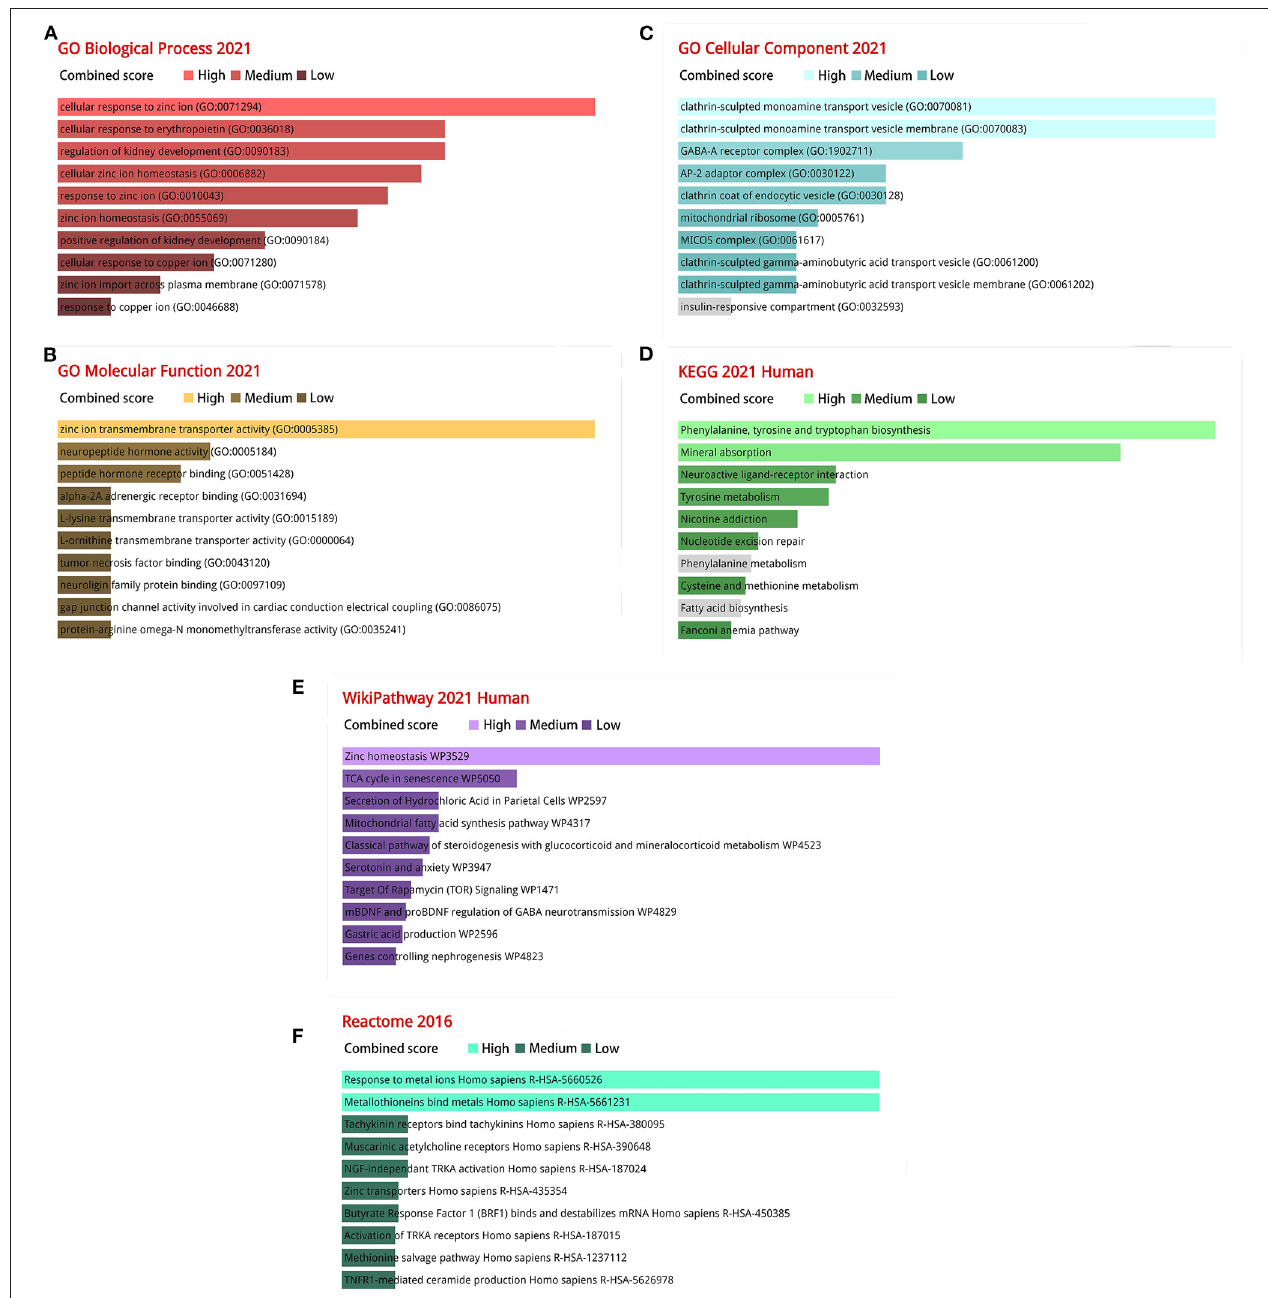
FIGURE 3 | The bar charts of ontological and pathway enrichment analysis of DEGs. (A) Go biological processes; (B) Go molecular function; (C) Go cellular component; (D) KEGG human pathway 2021; (E) Wikipathway 2021; (F) Reactome pathway 2016.